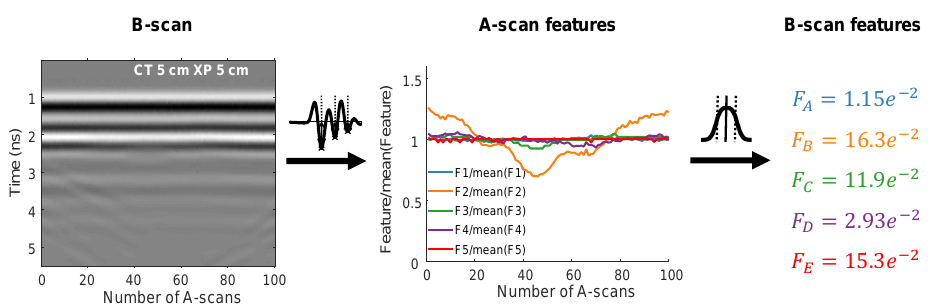
Figure 8. Processing steps to extract A- and B-scan